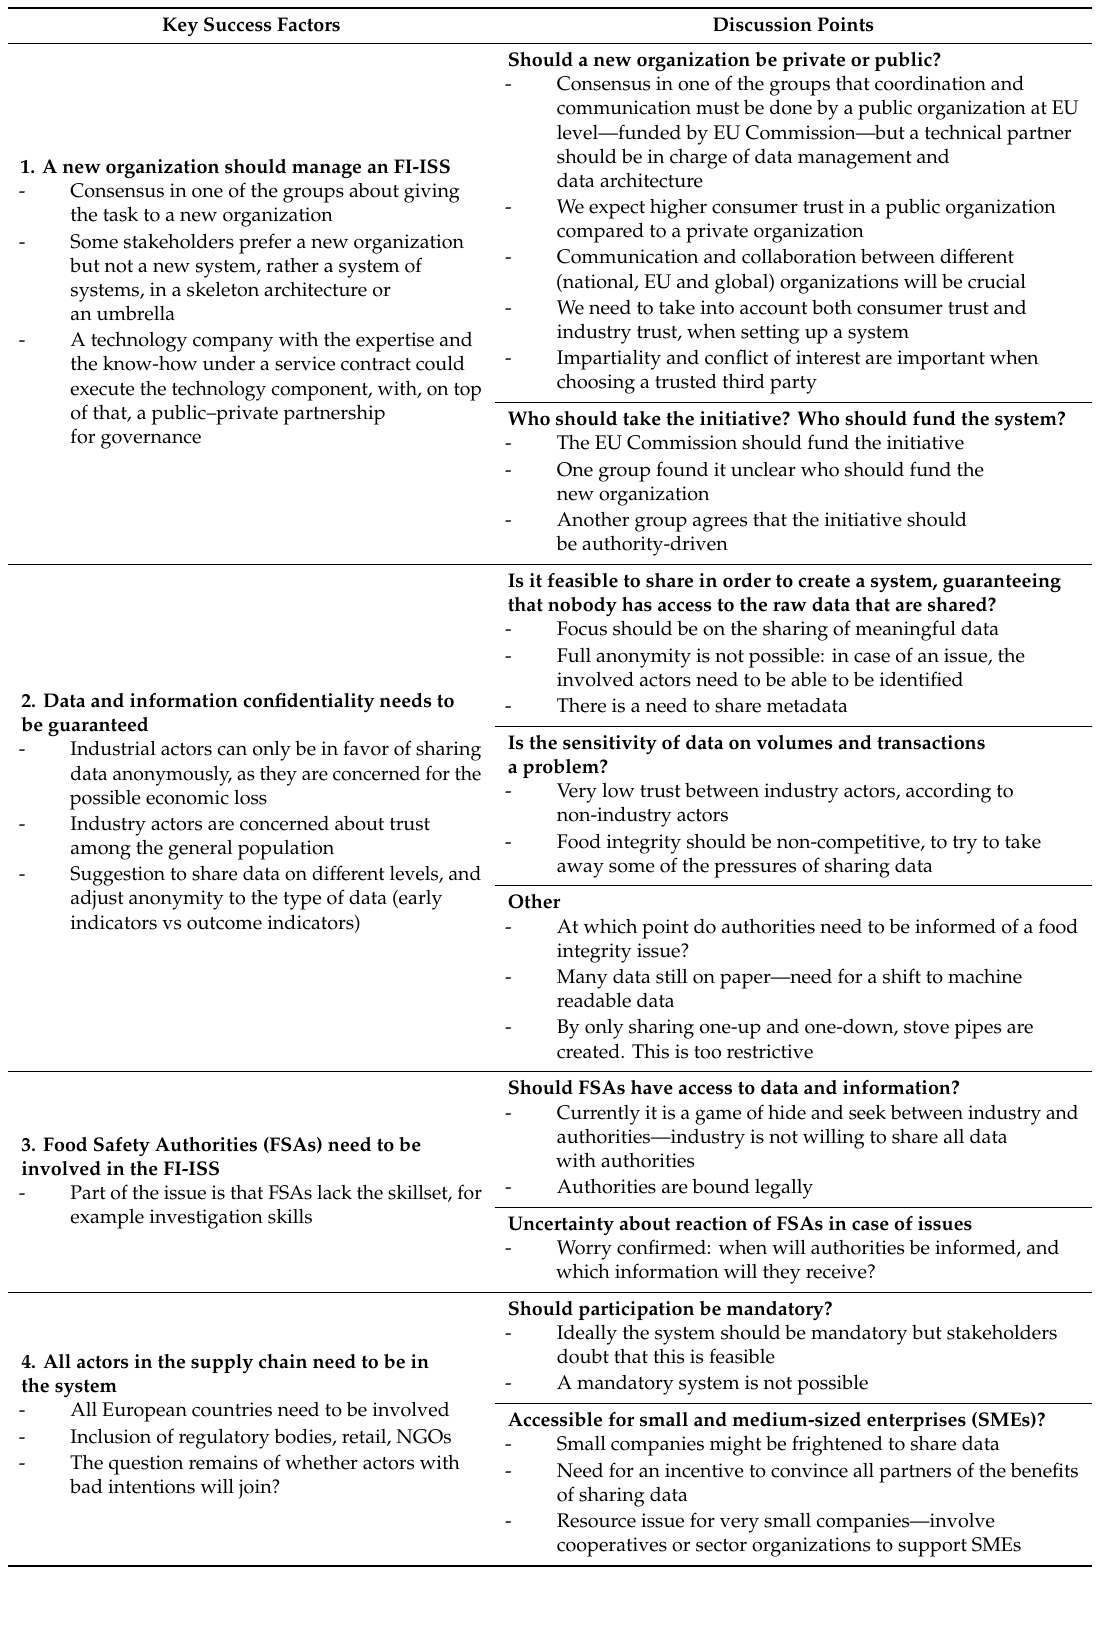
Table 3. Summary of points raised by the stakeholders during the working group sessions in round 3 (May